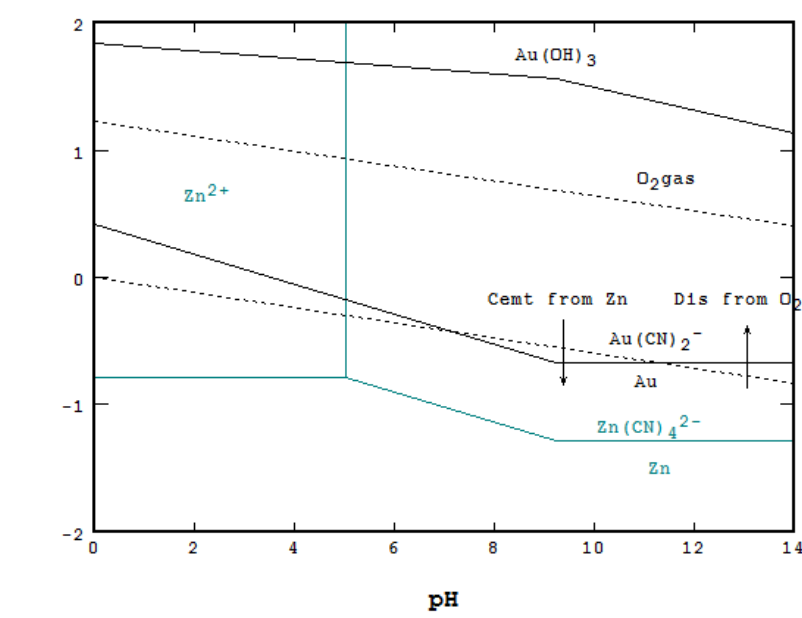
Figure 19. Combined Au–CN and Zn–CN Eh-pH diagrams would show leaching and cementation for the gold cyanidation process.